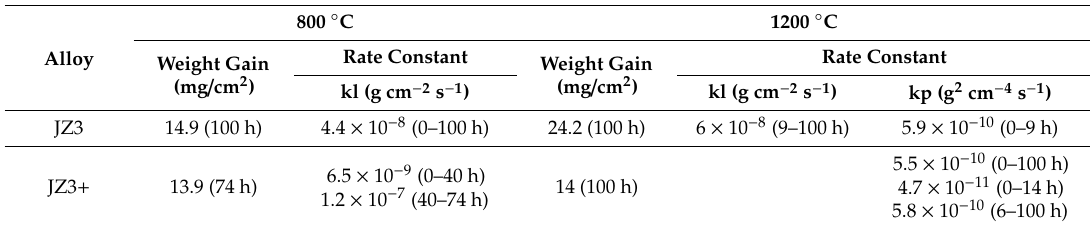
Figure 7. Thermogravimetric (TG) data; ( a , b ) for 800 ◦ C and ( c , d ) for 1200 ◦ C, ( a , c ) alloy JZ3 and ( b , d ) alloy JZ3 + . Table 3. Weight gains and linear (k l ) and parabolic (k p ) oxidation rate constants of the alloys JZ3 and JZ3 + after isothermal oxidation at 800 and 1200 ◦ C for 100